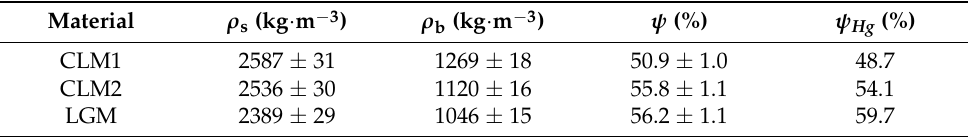
Table 4. The macrostructural properties of the hardened plasters.